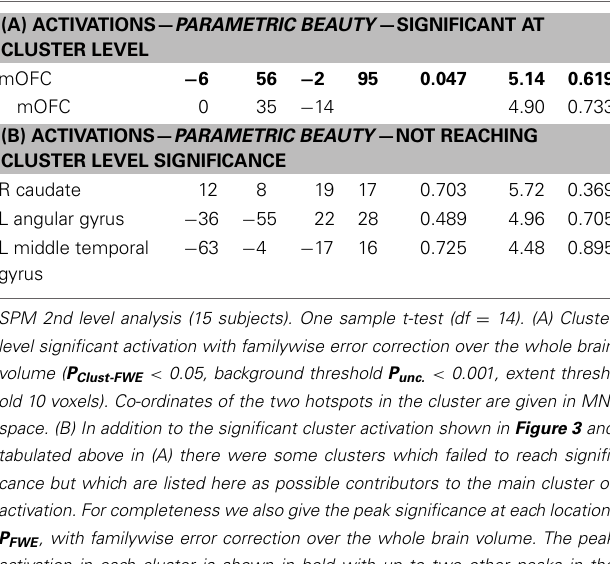
Table 1 | Activation for the contrast parametric beauty . Location x y z k E P Clust-FEW T 14